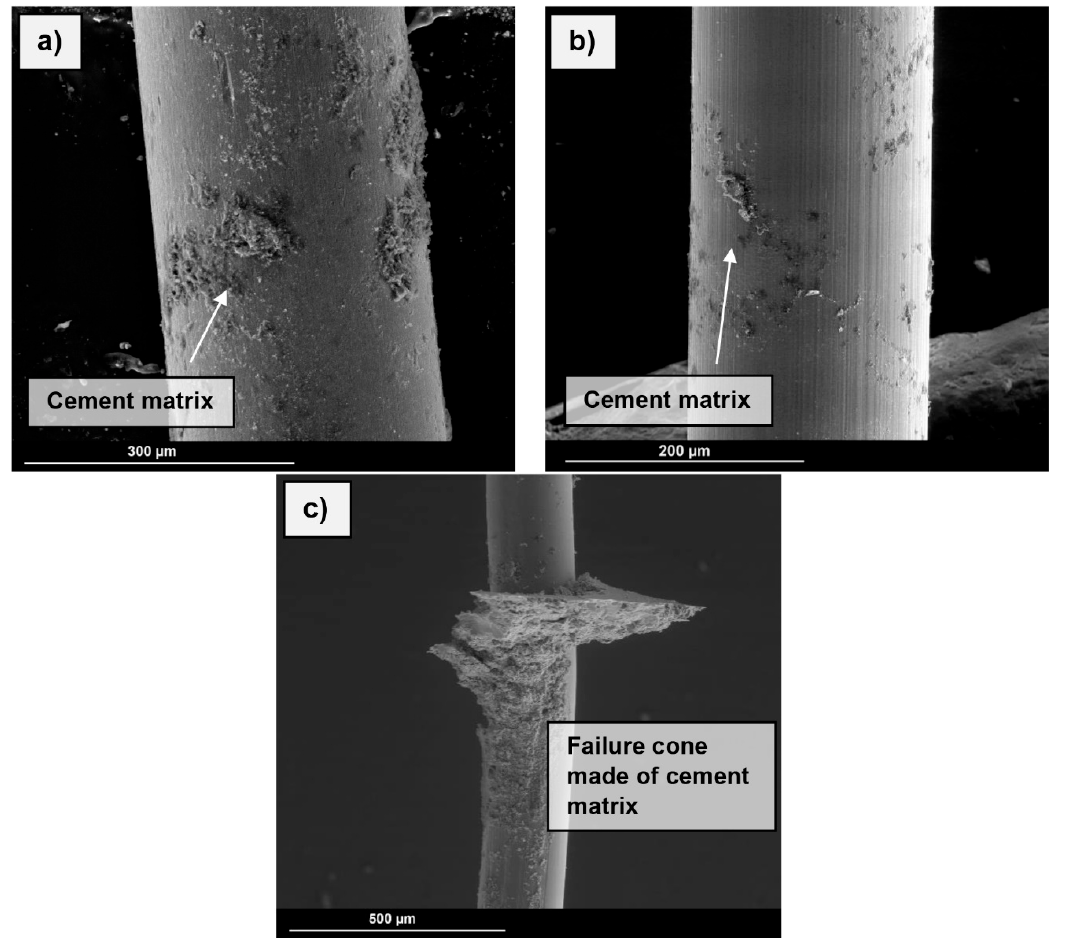
Figure 9. Secondary electron images of the embedded parts of the pullout fibres; ( a ) Boundary between the embedded and blank part of a SF. ( b ) Boundary between the embedded and blank part of a SMA fibre. ( c ) Boundary between the embedded and blank part of a SSF. Image in low-vacuum mode, voltage 15 kV, working distance 10 mm.